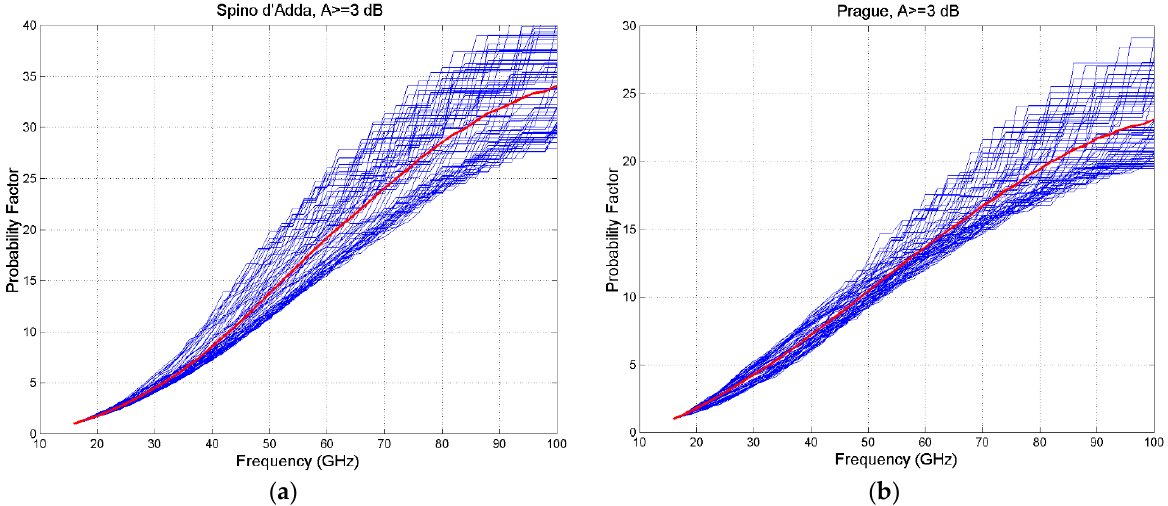
Figure 5. Probability factor ρ ( A , f ) as function of frequency, for fixed values of A ranging approximately from 3 to about 30 dB in 0.2 dB steps (blue continuous curves): ( a ) for Spino d’Adda; ( b ) Prague. The red curve is the average value ρ m ( f ) , a parameter independent of attenuation. Notice the different ordinate range.